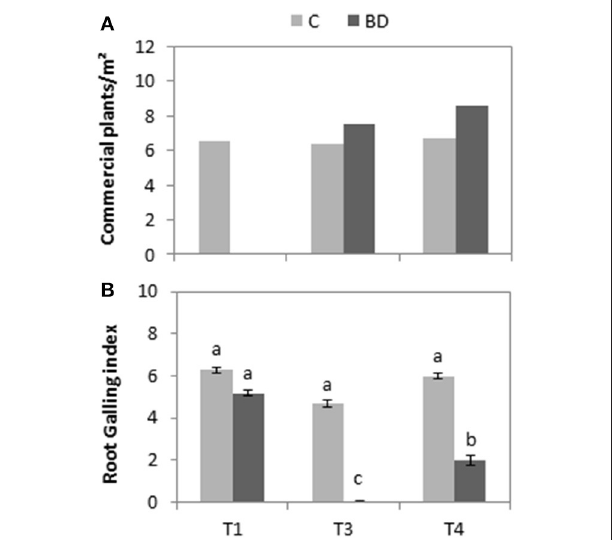
FIGURE 4 | (A) Average and standard errors for root galling index according to root-knot nematode rating chart by Bridge and Page (1980) of lettuce plants. (B) Number of commercial lettuces collected. For both, lettuce were collected from the biodisinfested (BD) and control (C) plots at three different times: T1 (pre-treatment), T3 (post-crop after treatment) and T4 (1 year after treatment). Values with the same letter are not significantly different among time and treatment combinations according to Tukey HSD test ( P <